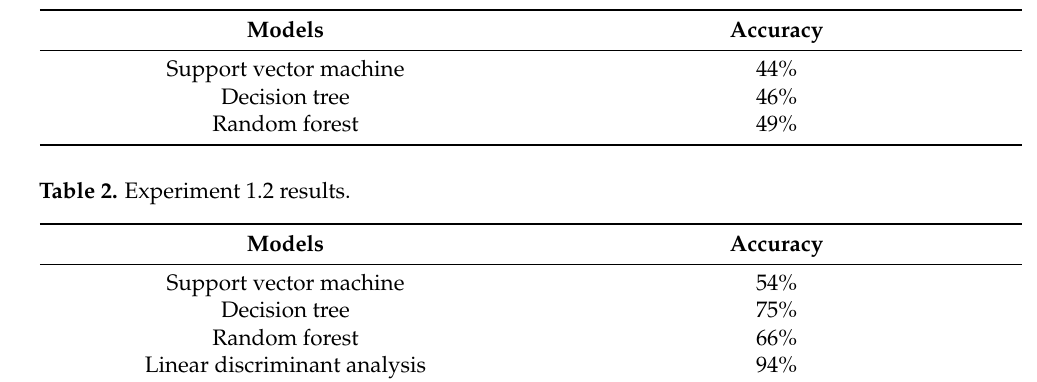
Table 1. Experiment 1.1 results.